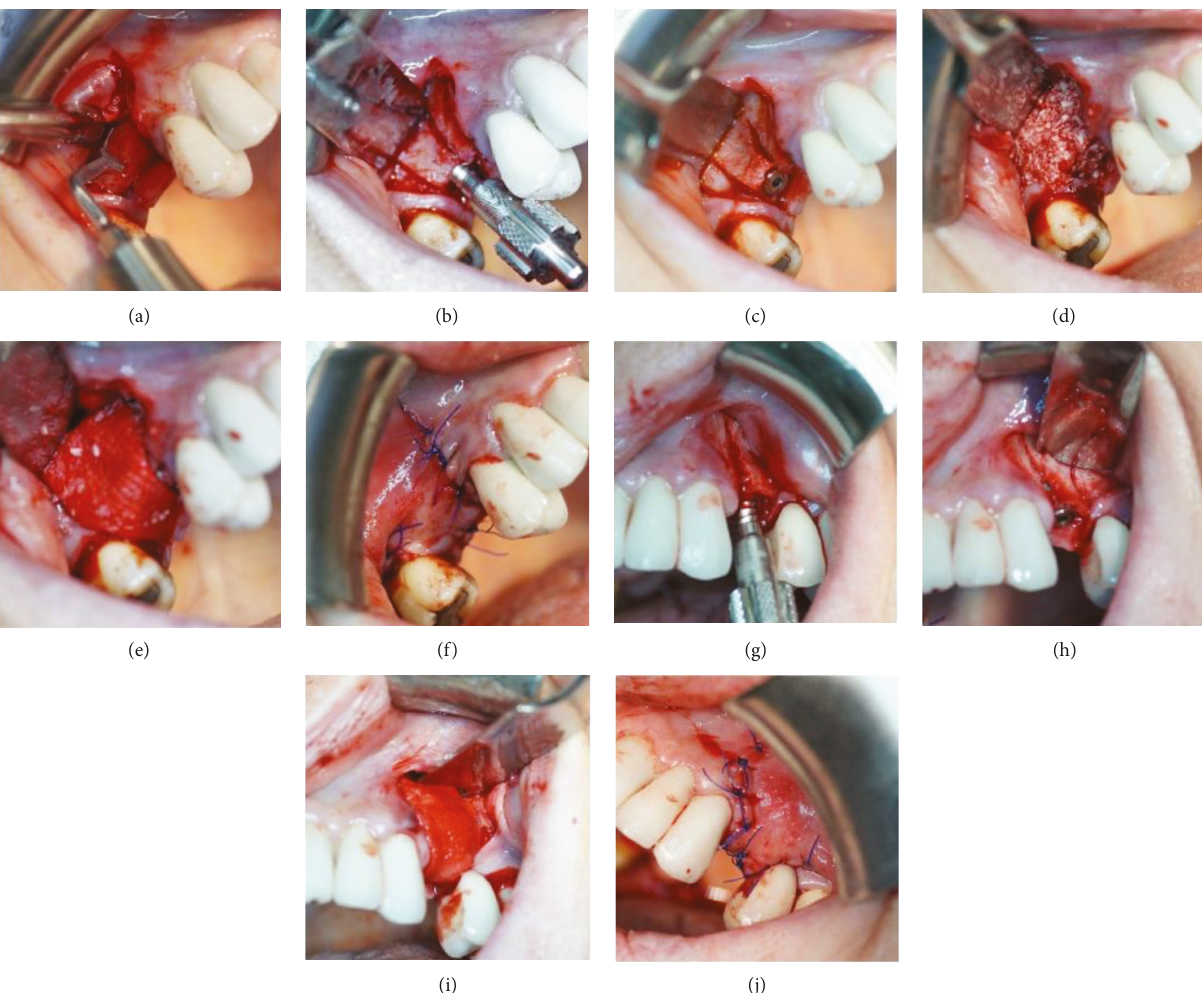
Figure 2: Ridge splitting with immediate placement of implants. (a) Bone osteotomy using piezosurgery. (b) Bone spreading with hand instruments. (c) The implant placement on the right side of the maxilla. (d) Alloplastic material grafting. (e) Collagen membrane placement. (f) Sutures. (g) Bone spreading with hand instruments on the left side of the maxilla. (h) The implant placement on the left side of the maxilla. (i) Placement of alloplastic material and collagen membrane. (j)